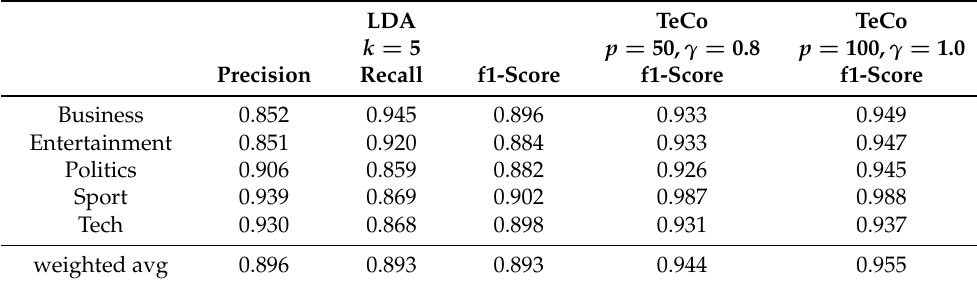
Table 11. Crosstable between preassigned classes and detected dominant topics according to LDA with k = 5 for all documents of the BBC corpus; to be compared with Tables 4 and 8. Topic Class Economy Music & Films Politics Sports Technology Business 482 4 14 0 10 Entertainment 14 355 7 1 9 Politics 40 348 Table 12. Classification statistics for predicting preassigned classes by detected dominant topics from LDA with k = 5; to be compared with Tables 5 and 9. For easier direct comparison, we repeat the f1-scores of those Tables here in the rightmost two columns. LDA TeCo TeCo k = 5 p = 50, γ = 0.8 p = 100, γ = 1.0 Precision Recall f1-Score f1-Score